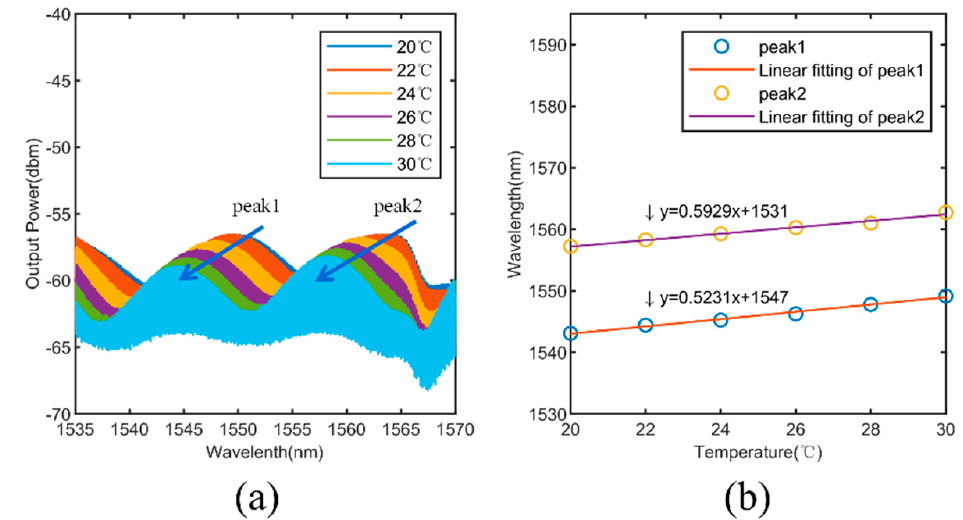
Figure 10. ( a ) Sample 4: Output spectrums under a temperature range of 20–30 °C. ( b ) Linear fitting of characteristic wavelength (peaks) shifting for temperature response.